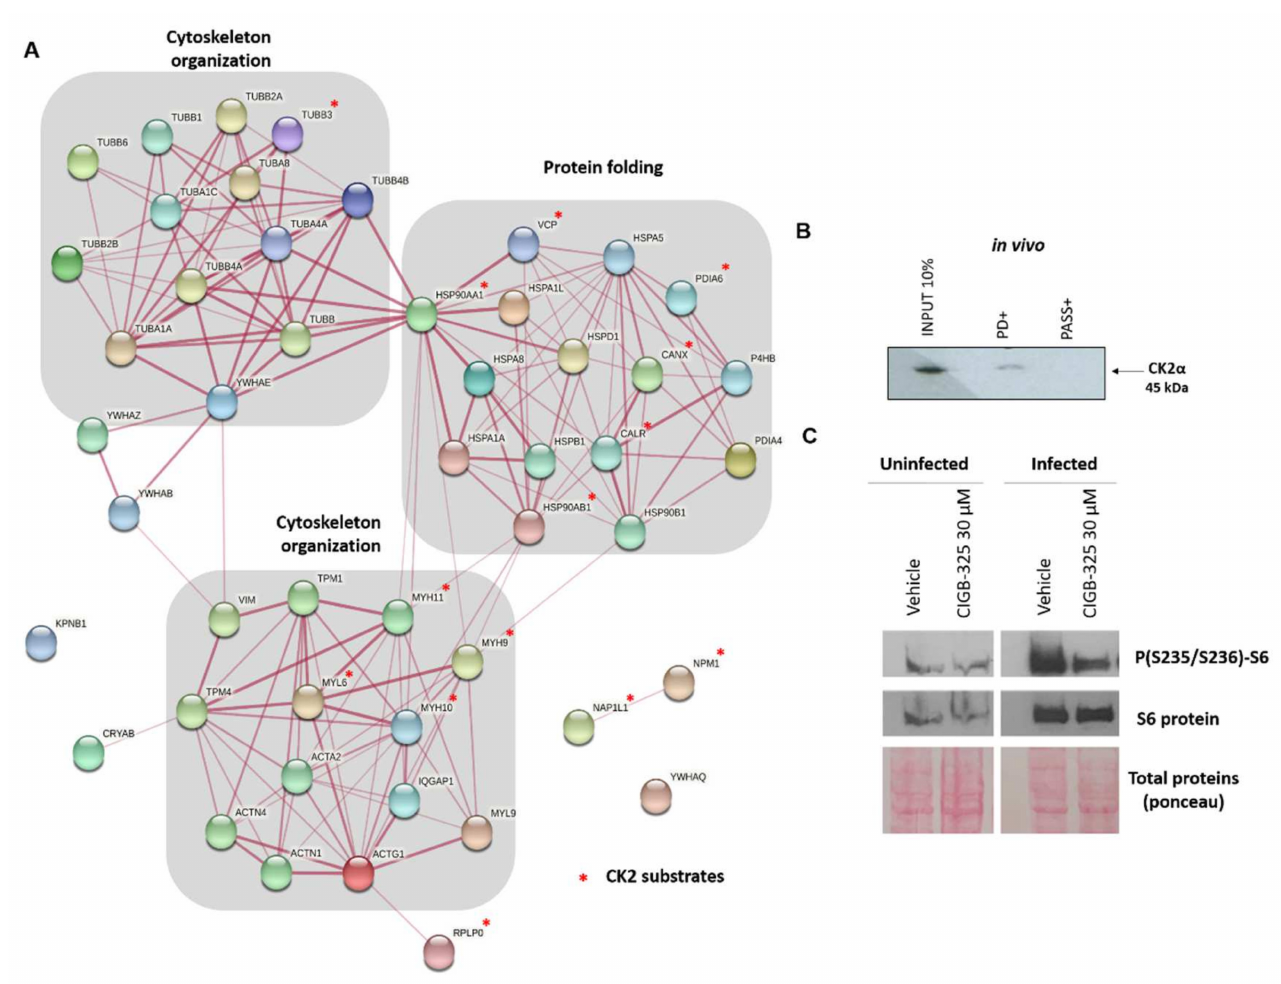
Figure 4. CIGB-325-host interacting proteins in BCoV-infected MDBK cells and effect of the peptide on RPS6 phosphorylation. ( A ) Network was generated using information gathered from the STRING database. Biological processes retrieved from the Gene Ontology database are indicated, and CK2 bona fide substrates are indicated with an asterisk in red. ( B ) In vivo pull-down was performed with biotinylated CIGB-325 as bait to capture CK2 in MDBK-infected cells. Interacting proteins were then resolved by 12% SDS-PAGE, transferred, and each fraction was inspected by Western blot with the antibody against CK2 α . ( C ) Effect of CIGB-325 on phosphorylated and total protein levels of RPS6. MDBK cells were infected with BCoV-Mebus (70,000 TCID 50 /well). After 24 h of viral challenge, CIGB-325 was incubated for 45 min, and preparation of cell extracts for Western blot was carried out, as referred to in Material and